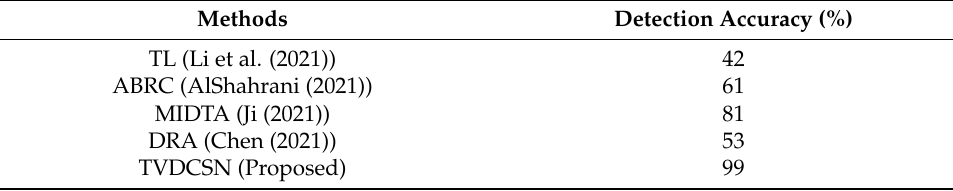
Figure 6. Proposed and existing methods of detection accuracy. Figure 5. Proposed and existing methods of detection accuracy. Table 1. Values of proposed and existing methods of detection accuracy.